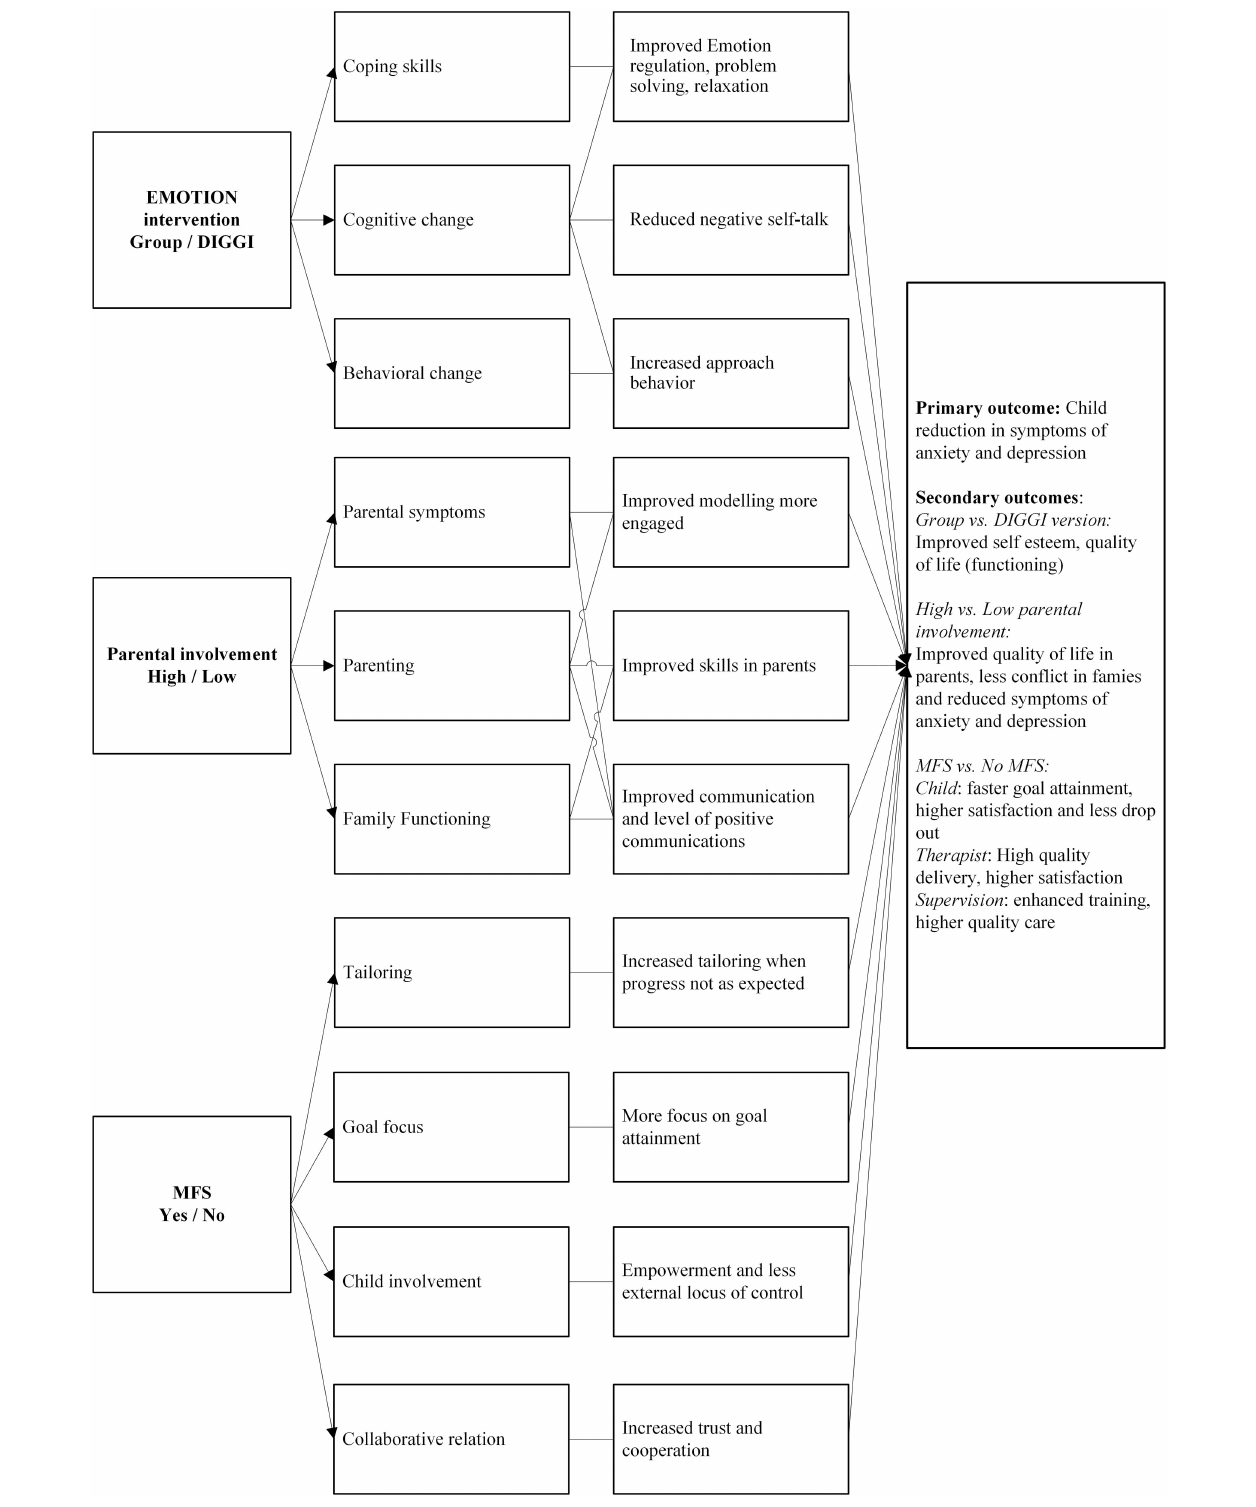
FIGURE 1 | The conceptual model of the ECHO study. The model depicts how different components in the study will impact mediators and combine to produce change in primary and secondary outcomes.